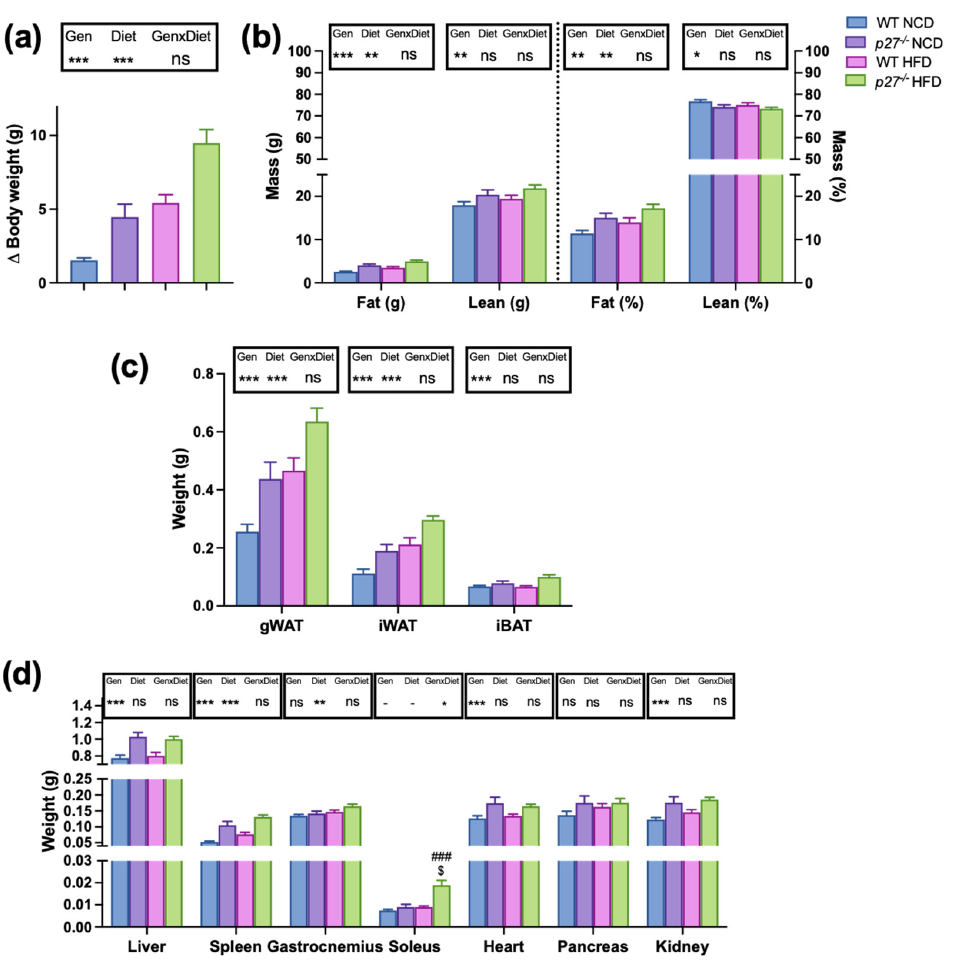
Figure 1. Mice lacking p27 gain more weight and have larger WAT and BAT depots than WT mice. ( a ) Body weight gain after 10 weeks of study in WT and p27 -/- mice fed with normal chow diet (NCD) or a high fat diet (HFD). ( b ) Whole body fat and lean mass (in g or as percentage of body weight) in WT and p27 -/- mice fed with NCD or HFD for 10 weeks. ( c ) Weights of different adipose tissue depots: gonadal (gWAT) and inguinal (iWAT) and interscapular brown (iBAT) collected after the sacrifice in WT and p27 -/- mice fed with NCD or HFD for 10 weeks. ( d ) Weights of different organs collected after the sacrifice in WT and p27 -/- mice fed with NCD or HFD for 10 weeks. Data are expressed as mean ± SEM ( n = 11–25). The legend above subfigures shows the result of the two-way ANOVA analysis (* p < 0.05, ** p < 0.01, *** p < 0.001, ns: non-significant). Gen, genotype; GenxDiet, interaction between genotype and diet. If an interaction (GenxDiet) was found, differences between groups were analysed by Student’s t -test. ### p < 0.001 vs. WT HFD. $ p < 0.05 vs. p27 -/- NCD.